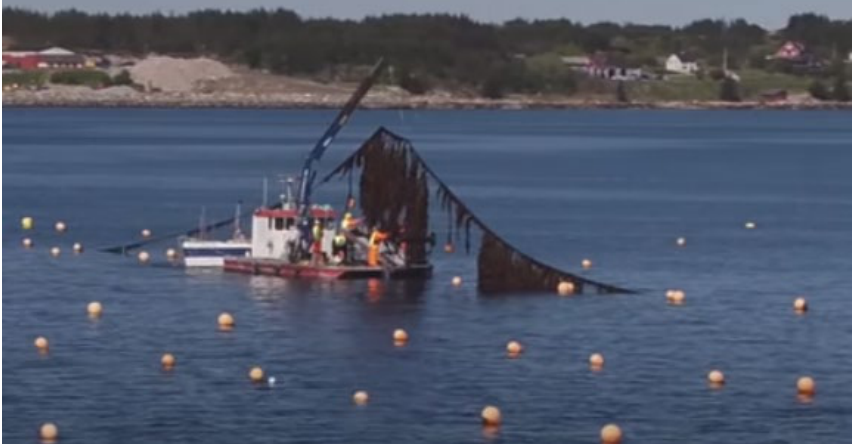
Figure 16. Crane manipulating longline with hand-over-hand harvesting—image from https://seaweedsolutions.com/ (accessed on 22 September 2022).